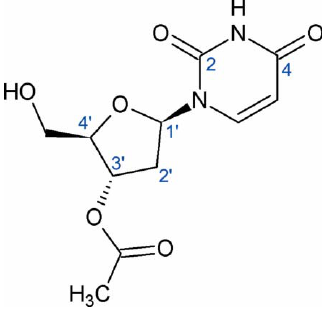
Experimental Crystal data